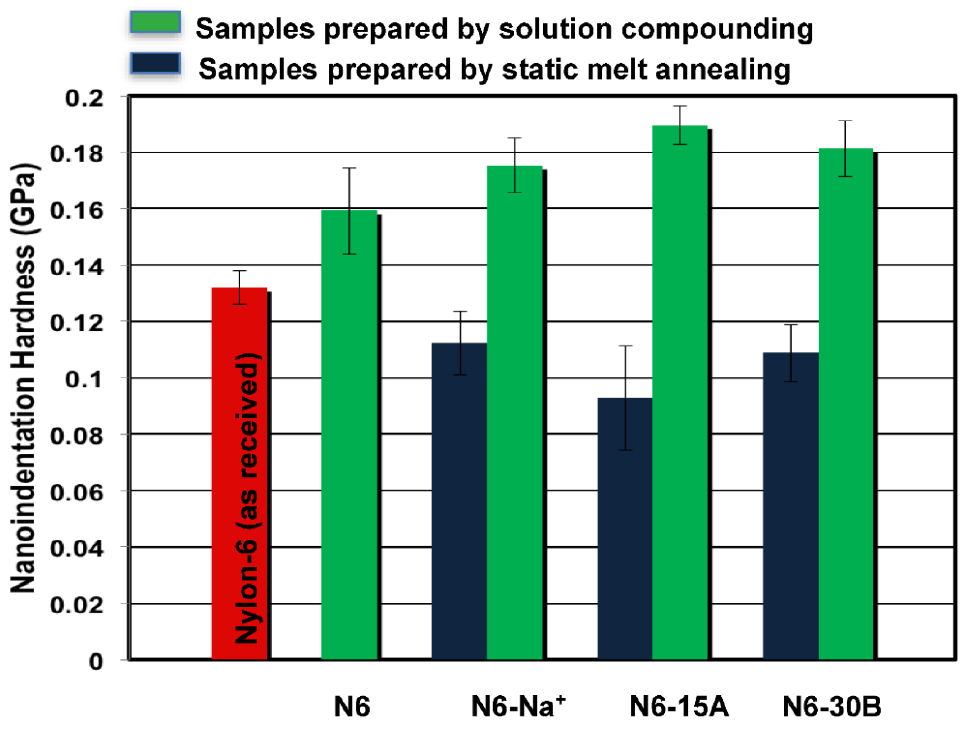
Figure 6. Average nanoindentation hardness values for the various samples